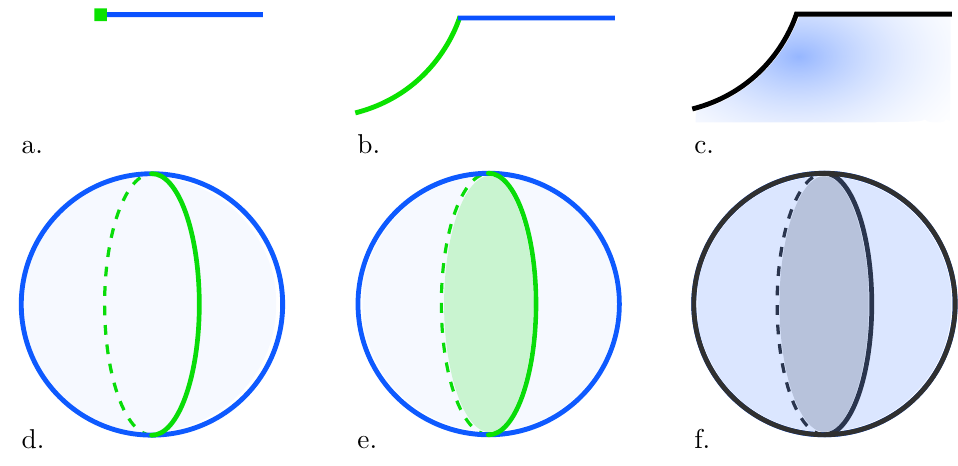
Figure 1. Illustration of doubly-holographic models: the top row illustrates (a time slice of) the three perspectives of the model in [15], while the bottom row displays the analogous descriptions of our construction in higher dimensions [1]. In the latter, we are using the global conformal frame where the boundary CFT lives on R × S d − 1 and the conformal defect appears on the equator of the ( d − 1 )-sphere — see discussion in section 2 and [1]. The bottom row reduces to the top upon setting d = 2 and taking a Z 2 quotient across the defect in the boundary or the brane in the bulk. The boundary, brane and bulk gravity perspectives correspond to panels a & d, b & e, and c & f,